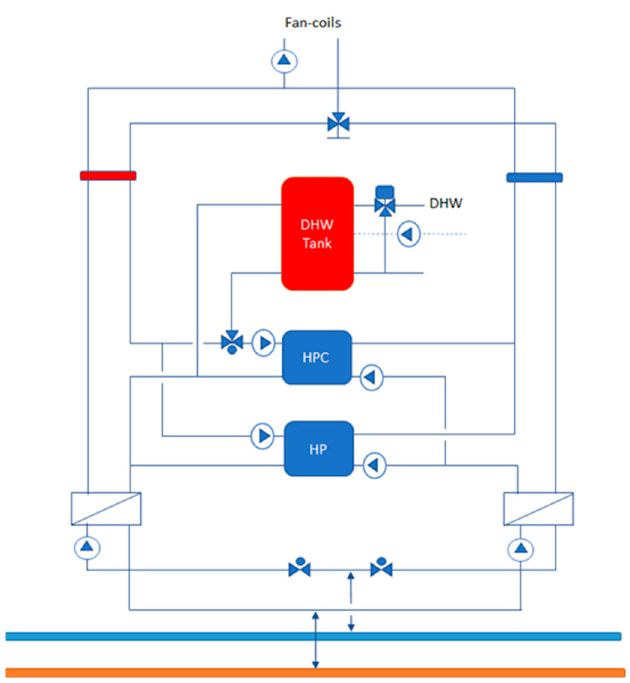
Figure 5. Schematic of a building substation.